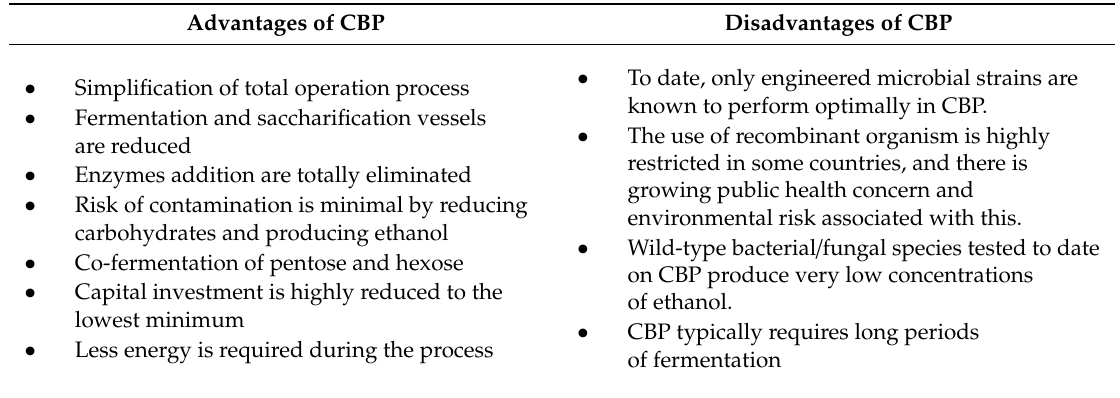
Table 1. Advantages and disadvantages of CBP